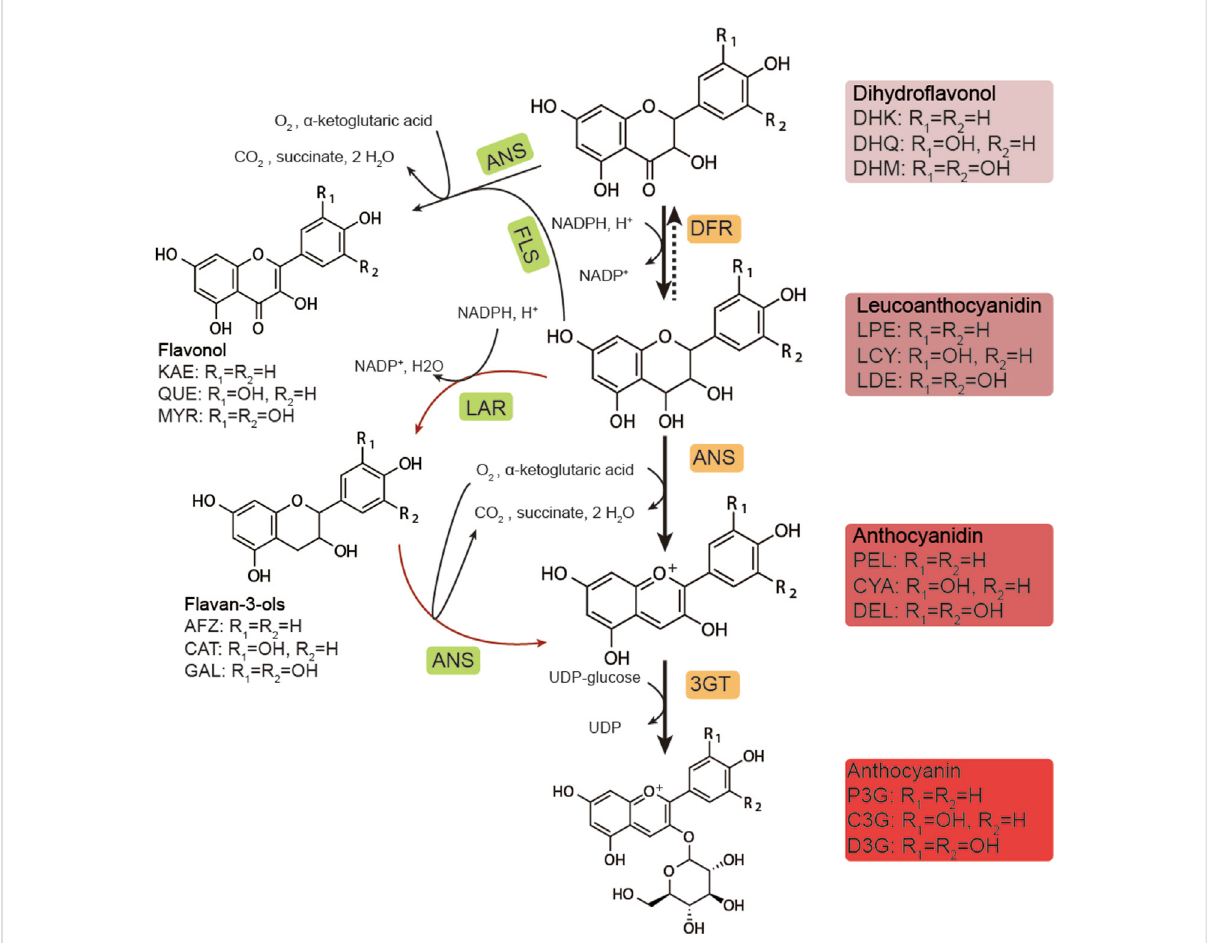
FIGURE 1 Biosynthetic pathway of anthocyanins. DHK, dihydrokaempferol; DHQ, dihydroquercetin; DHM, dihydromyricetin; LPE, leucopelargonidin; LCY, leucocyanidin; LDE: leucodelphinidin; PEL, pelargonidin; CYA, cyanidin; DEL, delphinidin; P3G, pelargonidin-3- O -glucoside; C3G, cyanidin-3- O -glucoside; D3G, delphinidin-3- O -glucoside; KAE, kaempferol; QUE, quercetin; MYR, myricetin; AFZ, afzelechin; CAT, catechin; GAL, gallocatechin; DFR, dihydro fl avonol-4-reductase; ANS, anthocyanidin synthase; 3GT, UDP-glucose fl avonoid 3- O -glucosyltransferase; FLS, fl avonol synthase; LAR, leucoanthocyanidin